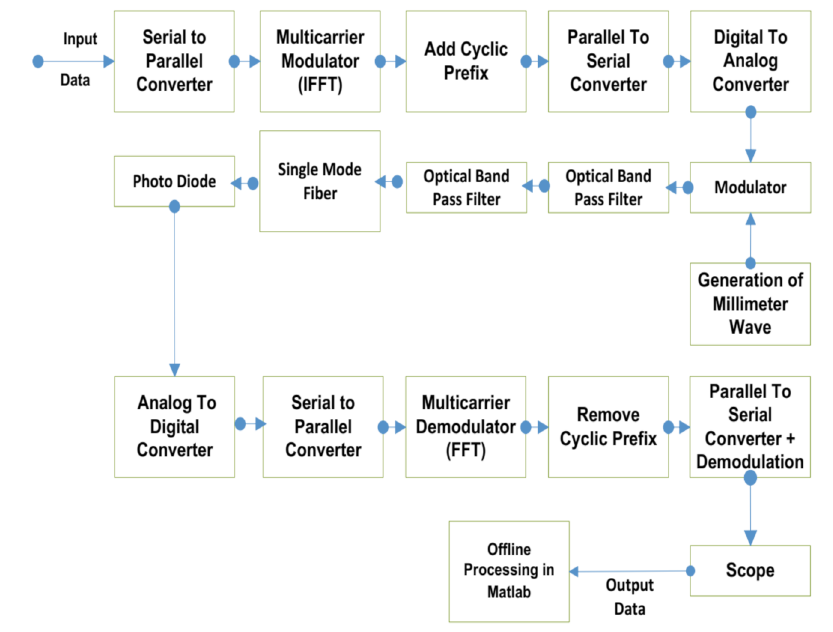
Figure 1. Block diagram of a converged 5G mm-wave A-RoF multicarrier OFDM digital commu- nication system consisting of an OFDM transmission chain, mm-wave generation and an OFDM reception